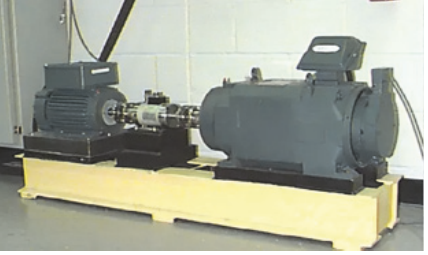
Figure 9: Experimental station of Case Western Reserve University.